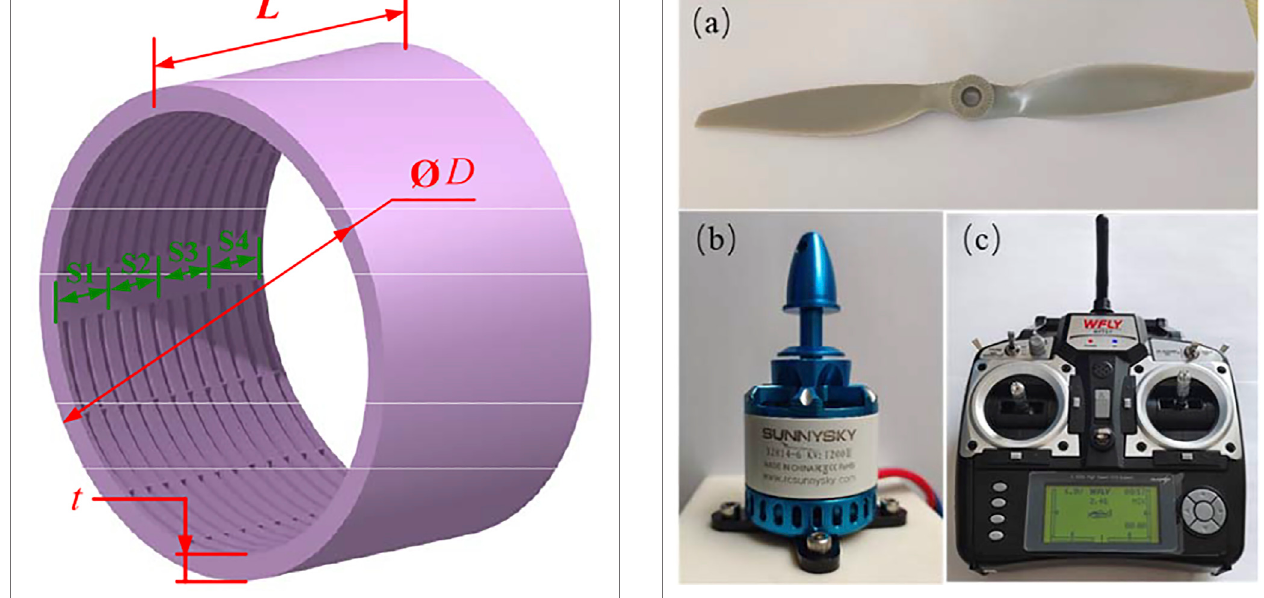
FIGURE 4 | Structure of the meta-liner duct. FIGURE 5 | Photographs of the (A) propeller, (B) motor, and (C)